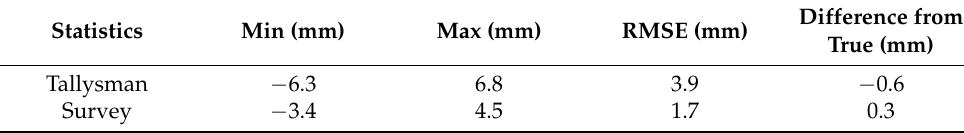
Table 5. Ellipsoid height statistics for the low-cost uncalibrated